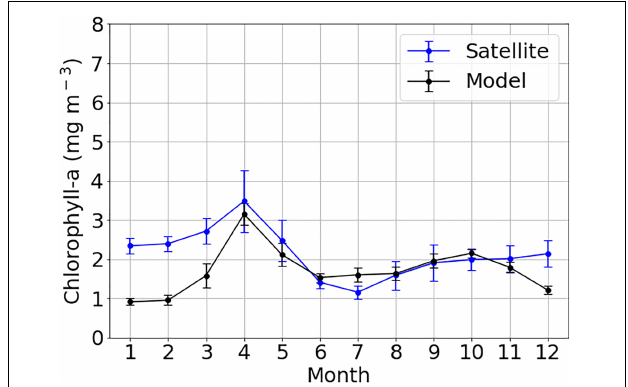
FIGURE 8 | Time-series of climatological monthly mean of chlorophyll- a concentrations from satellite data (blue line) and model outputs (black line) averaged over the central YS (121.5–125.5 ◦ E, 34.5–39.5 ◦ N) from 2006 to 2019 (units are mg m − 3 ). Vertical bars indicate the standard deviation of interannual variation. YS, Yellow Sea.